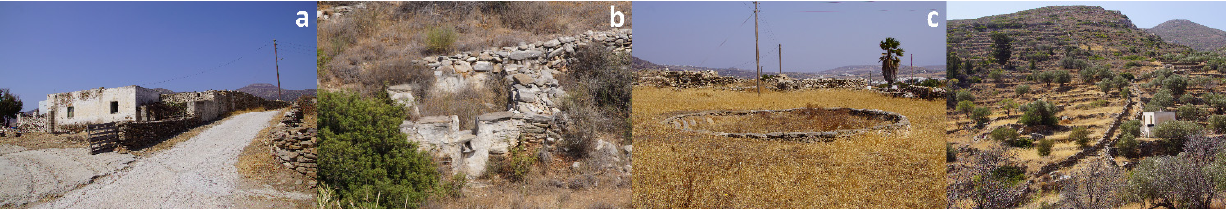
Figure 17. Various agricultural installations in the post-medieval and early modern countryside of Marpissa: ( a ). farmhouse and stables; ( b ). winepress; ( c ). threshing floor; ( d ). path and field terraces (photos by the